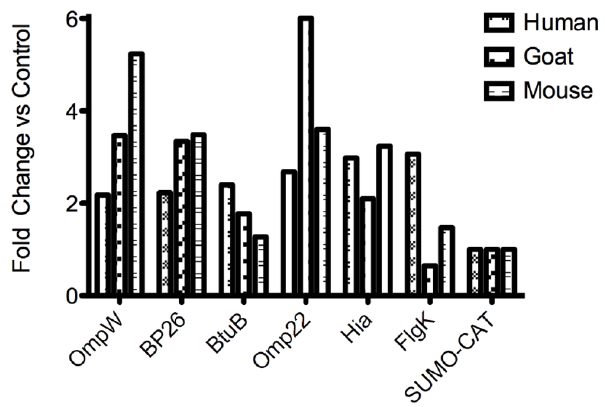
Figure 5. Western blot of pooled serum from exposed goats, mice, and humans to recombinant Brucella melitensis 16M outer membrane proteins. BL21 E. coli lysates overexpressing Brucella outer membrane proteins were electrophoresed and trans- ferred to a nitrocellulose membrane. Recombinant proteins were probed with serum absorbed against E. coli lysates overexpressing SUMO-CAT. Secondary antibodies labeled with HRP were used and cheluminescence used for signal development. Signals were developed in autoradiography film (A) and captured as Tiff images and analyzed with imageJ software (B). To determine fold change, signal intensity against Brucella proteins bands was divided by the intensity produced against control protein SUMO-CAT.